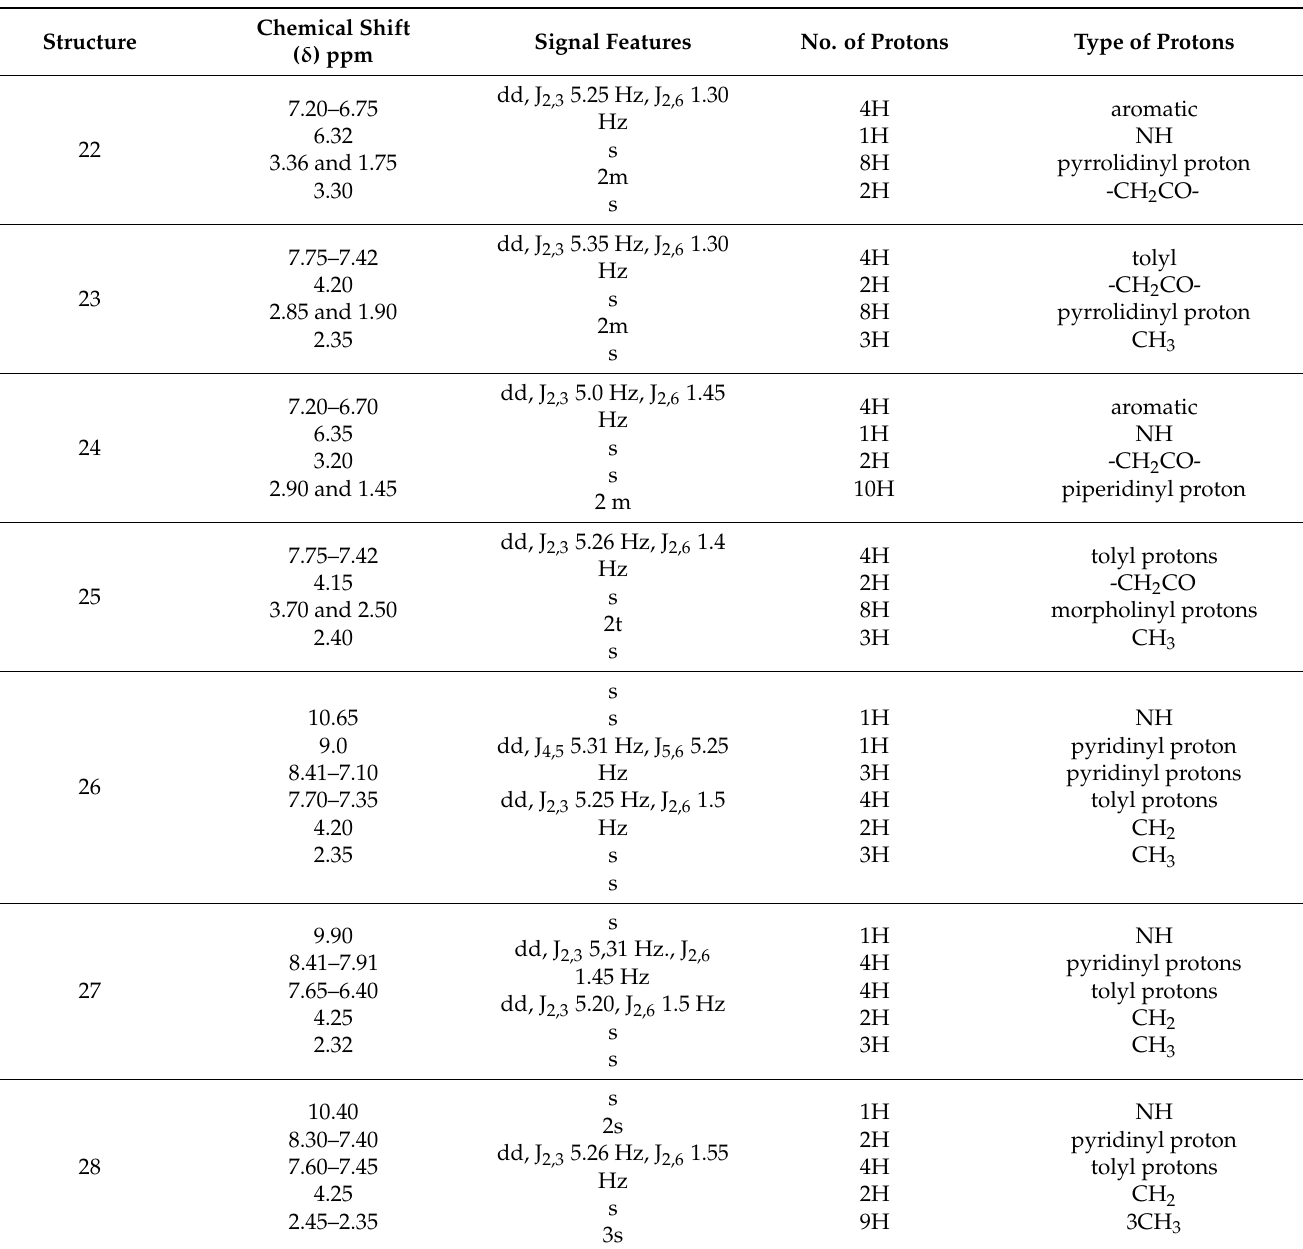
Table 2. 1 H-NMR data of compounds 22 – 28